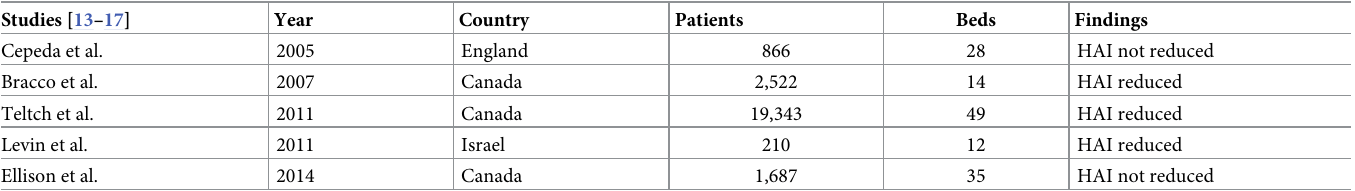
Table 1. Five previous studies of private rooms and hospital-acquired